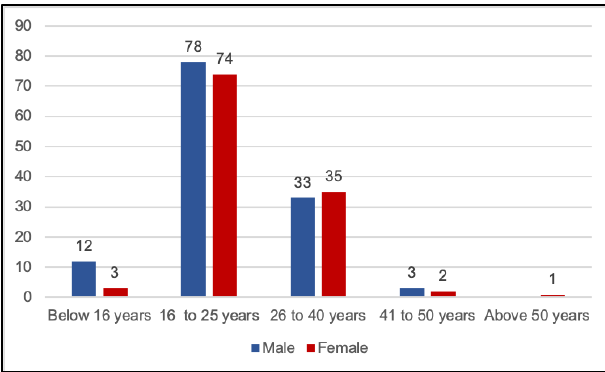
Figure 6. Participants by gender and